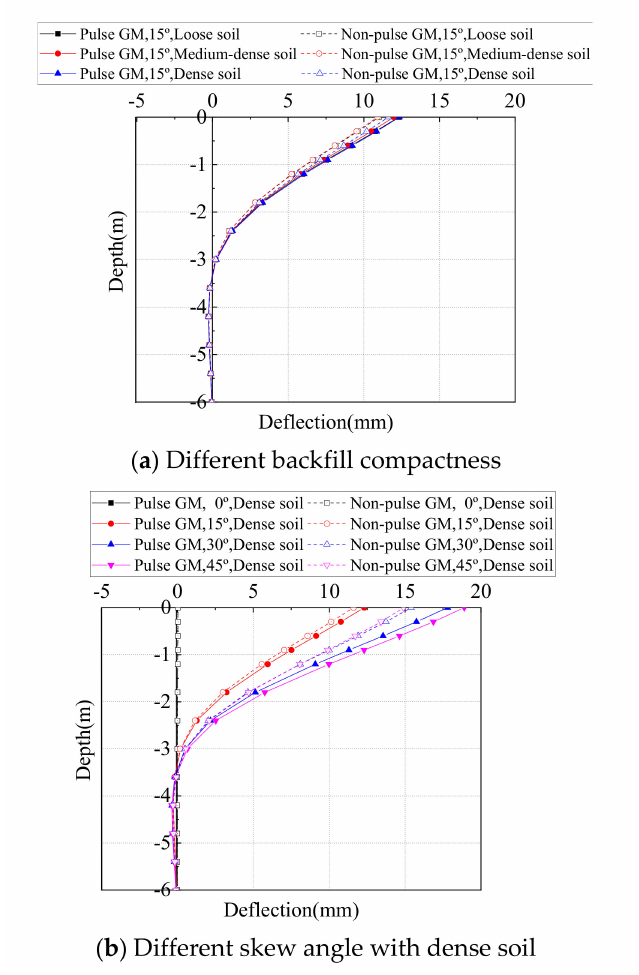
Figure 15. Distribution of pile deflections along the depth in the transverse direction. The maximum longitudinal and transverse deflection at the top of Steel H piles from time-history analyses on all SIAB models with varying skew angles and